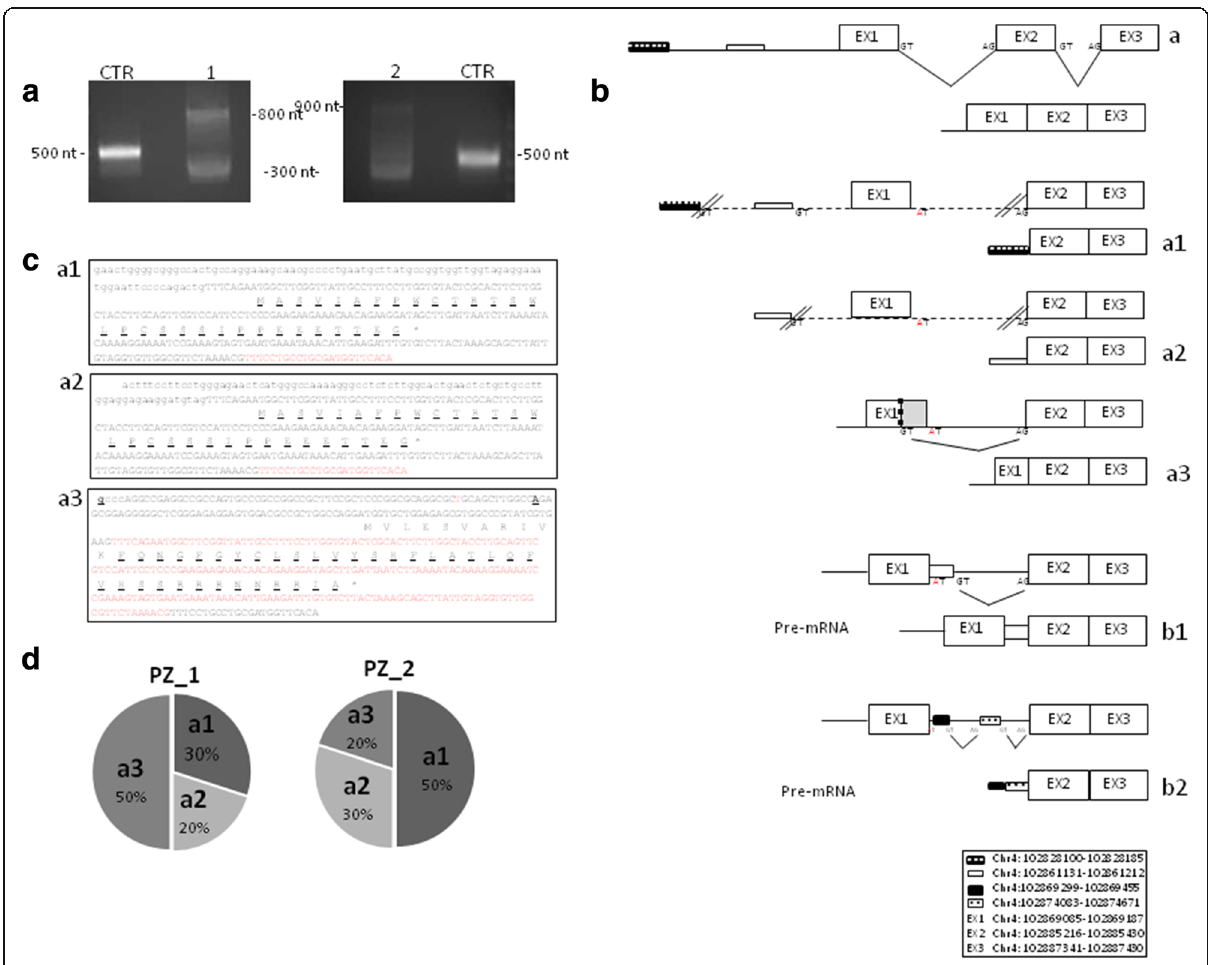
Fig. 2 Multiple truncated and non functional CISD2 isoforms. a The 5 ′ -RACE extended an expected 500 nt PCR product in the healthy control and two products of approximately 400 and 800 – 900 bases in the probands. b A schematic representation of the exon structure of wild-type (a) and mutant (a1-a3) CISD2 variants, and putative pre-mRNAs (b1 and b2). The homozygous mutation in the donor splice of intron 1 generated multiple transcripts characterized by the whole or partial absence of exon 1 (a1-a3) and inefficiently spliced pre-mRNAs retaining a large segment of intron 1 (b1 and b2). c The sequencing resulting from the 400 nt 5 ′ -RACE products. The cDNA and amino acids sequences are shown. The exons are indicated in uppercase letters and alternate colours. The 5 ′ -UTR is indicated in black lowercase letters. a1 and a2: Short stretches of genomic DNA are joined to exon 2 perfectly spliced with exon 3. Genomic coordinates: Chr4:102,828,100 – 102,828,185 and Chr4:102,861,131 – 102,861,212, for a1 and a2 respectively. CpG island coordinates: Chr4:102,826,475 – 102,828,235. Pugo gene: Chr4:102,827,193 – 102,829,052. The ATG, predicted in the beginning of exon 2 (Chr4:102,885,223; NG_008636.2:21,246), shifted the open reading frame and introduced a downstream amino acid changes (underscored) in addition to premature stop. a3: The partial absence of exon 1 (Chr4:102,869,118 – 102,869,187; NG_008636.2:5141 – 5210) caused a frame shift, amino acids changes (underscored) and a premature stop. The transcriptional start sites are in bold letters and underscored, and they are located at 111 and 43 nt upstream the ATG for patient 1 and 2, respectively (position at 4997 and 5064 referred to NG_008636.2; position at 102868974 and 102,869,041 referred to Chr4). The SNP rs223332 (NG_008636.2: g.5052G>T) is indicated in red and lowercase letter. d The frequency of mutant isoforms in WFS2